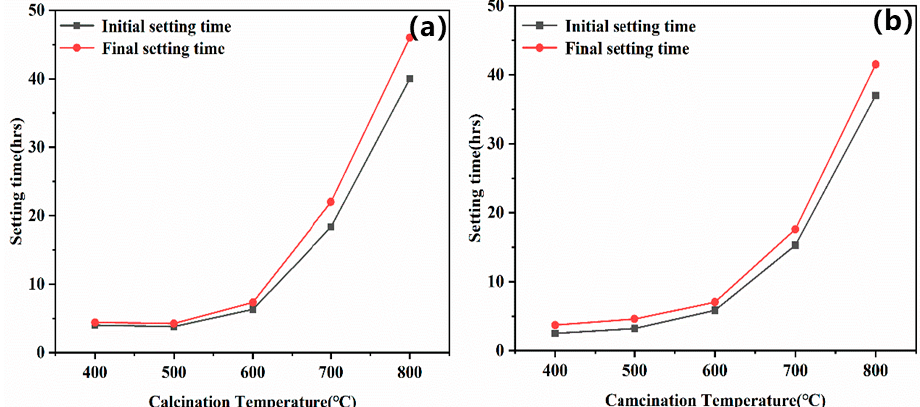
Materials 2021 , 14 , x FOR PEER REVIEW 11 of 17 Figure 8. Effect of the calcination temperature applied to obtain active magnesia on the setting time of MOC prepared with Baume degree of magnesium chloride solution equal to 24 ( a ) and 28 ( b ).